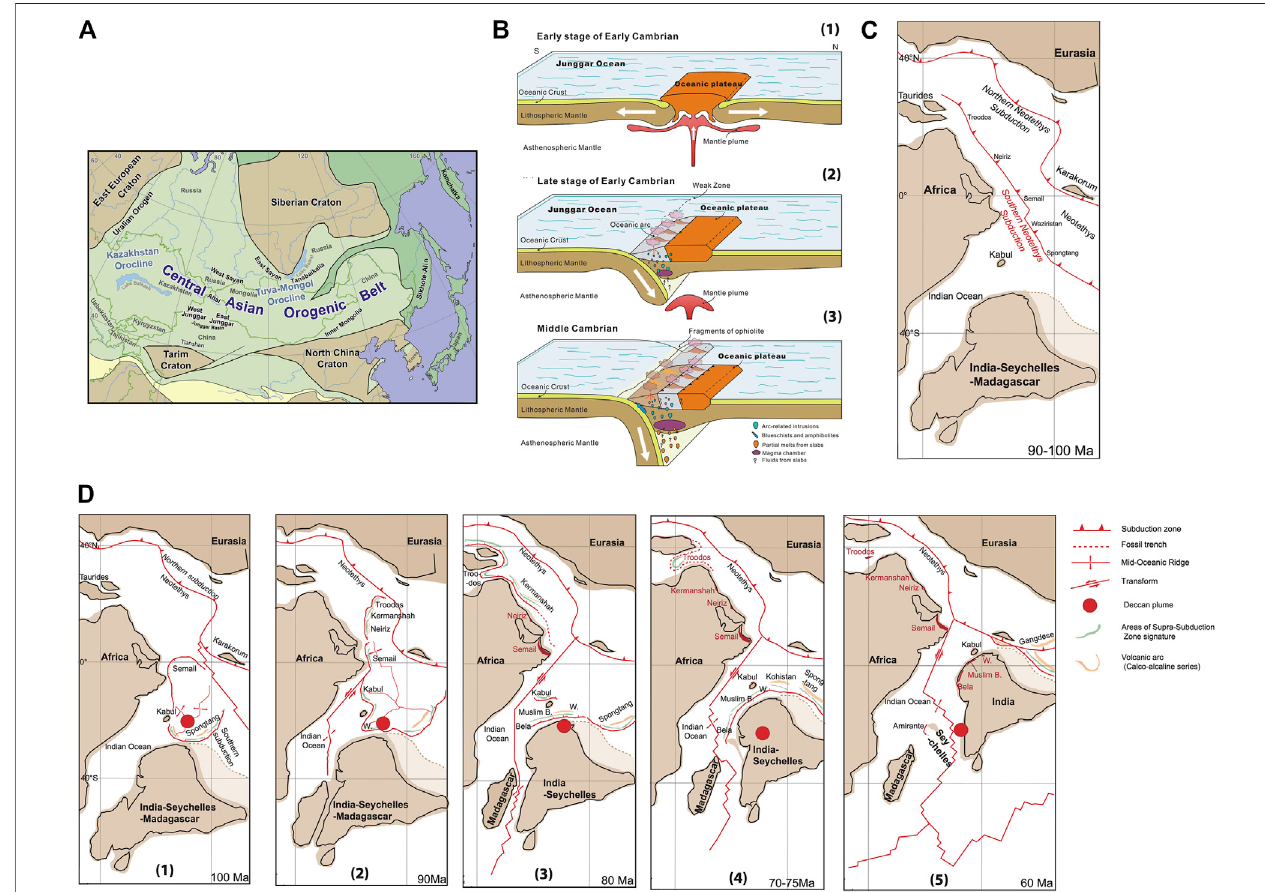
FIGURE 14 | (A) Present-day tectonic setting of the Central Asian Orogenic Belt (CAOB) (adapted from Windley and Xiao, 2018). (B) Model of Yang et al., 2020 illustrating the tectonic evolution of the Junggar Ocean in the Early-Middle Cambrian. (1) Arrival of a mantle plume beneath the Junggar Ocean led to lithospheric weakeningandgenerationofanoceanicplateau. (2) DensitydifferencesbetweenthenewlyformedplateauandnormalJunggaroceaniclithospherecausedinitiationofa newsubductionzone. (3) Subsequently,self-sustainingsubductiondeveloped(adaptedfromYangetal.,2020). (C,D) ReconstructionoftheNeotethysOceanand the con fi guration of the Southern Neotethys Subduction (adapted from Rodriguez et al., 2021). (C) Neotethys Ocean was subducted along perhaps two major subduction zones in the north and south. (D) (1) Southern Neotethys subduction at 100 Ma, 5 Myrs after initiation induced by the Deccan Plume. (2,3) Southern Neotethys subduction at 90 – 80 Ma. Interactions with the Kabul Block and the India-Africa transform boundary segmented the subduction zone into three independent slabs. (3,4) Southern Neotethys at 70 – 60 Ma. All three subduction branches deactivated after ophiolite emplacement.